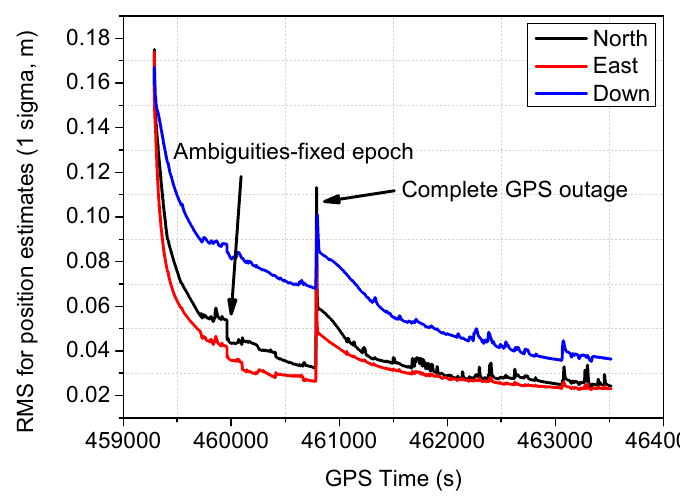
Figure 12. RMS for position estimates derived from the adaptive Kalman filter.